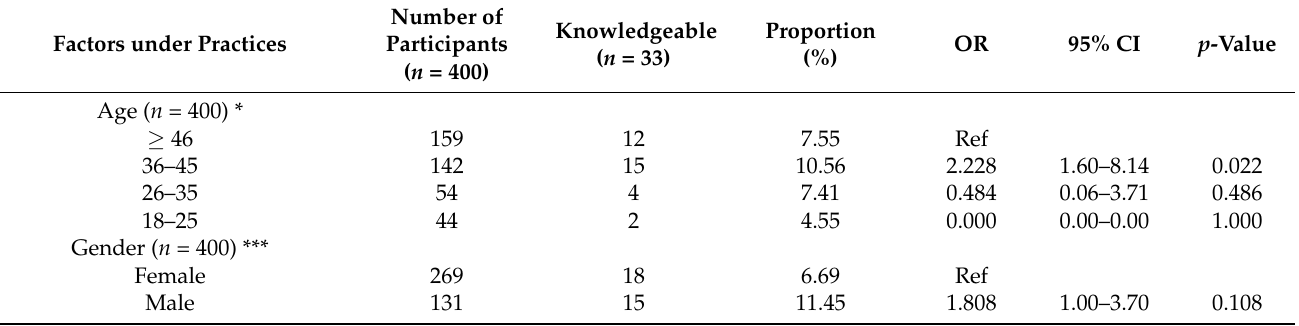
Table 7. Summary of univariate regression analysis of knowledge of RVF and potential predictors of management